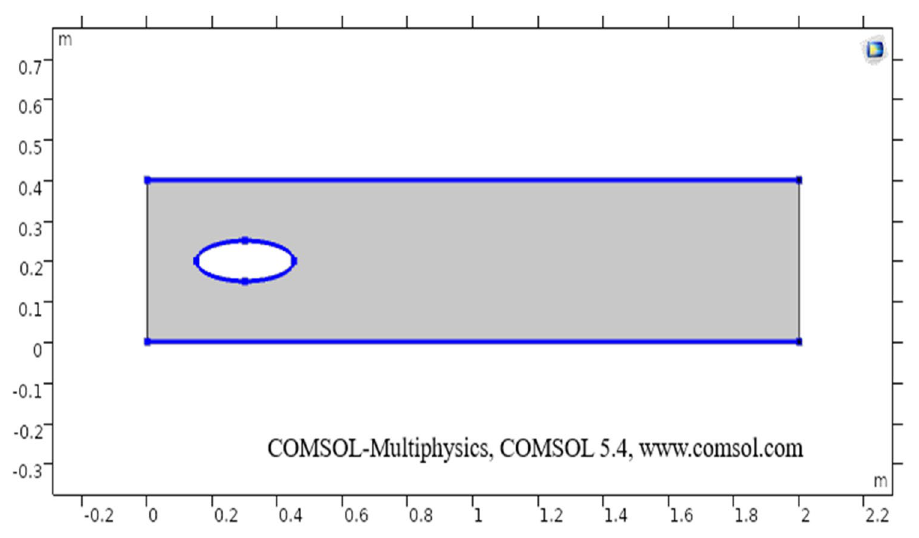
Figure 1. The sketch of two-dimensional elliptic cylindrical